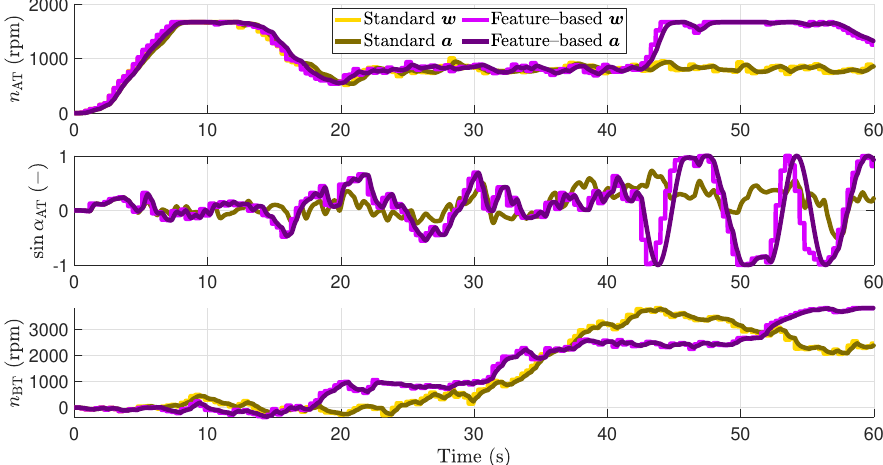
Figure 6. Comparison of the body–fixed surge velocity u and the velocity ˙ x in simulation. Consequently, the vessel controlled by the standard MPPI approach collides with the obstacle at full speed at t = 52.5 s. Regarding the input trajectories shown in Figure 7, the desired and actual actuator values are well fitting. Furthermore, in absence of an obstacle for t ≤ 44 s, the input trajectories show nearly the same behavior. To keep the surge velocity at 2 m/s, the AT is driven with about 950 rpm after it reaches its maximal value during the acceleration phase. While the AT is used to reach and keep the desired velocity, the BT is used to compensate the disturbances due to the river current. Using the feature-based MPPI approach for t > 44 s, the actuators’ trajectories lead to the braking behavior of the system.